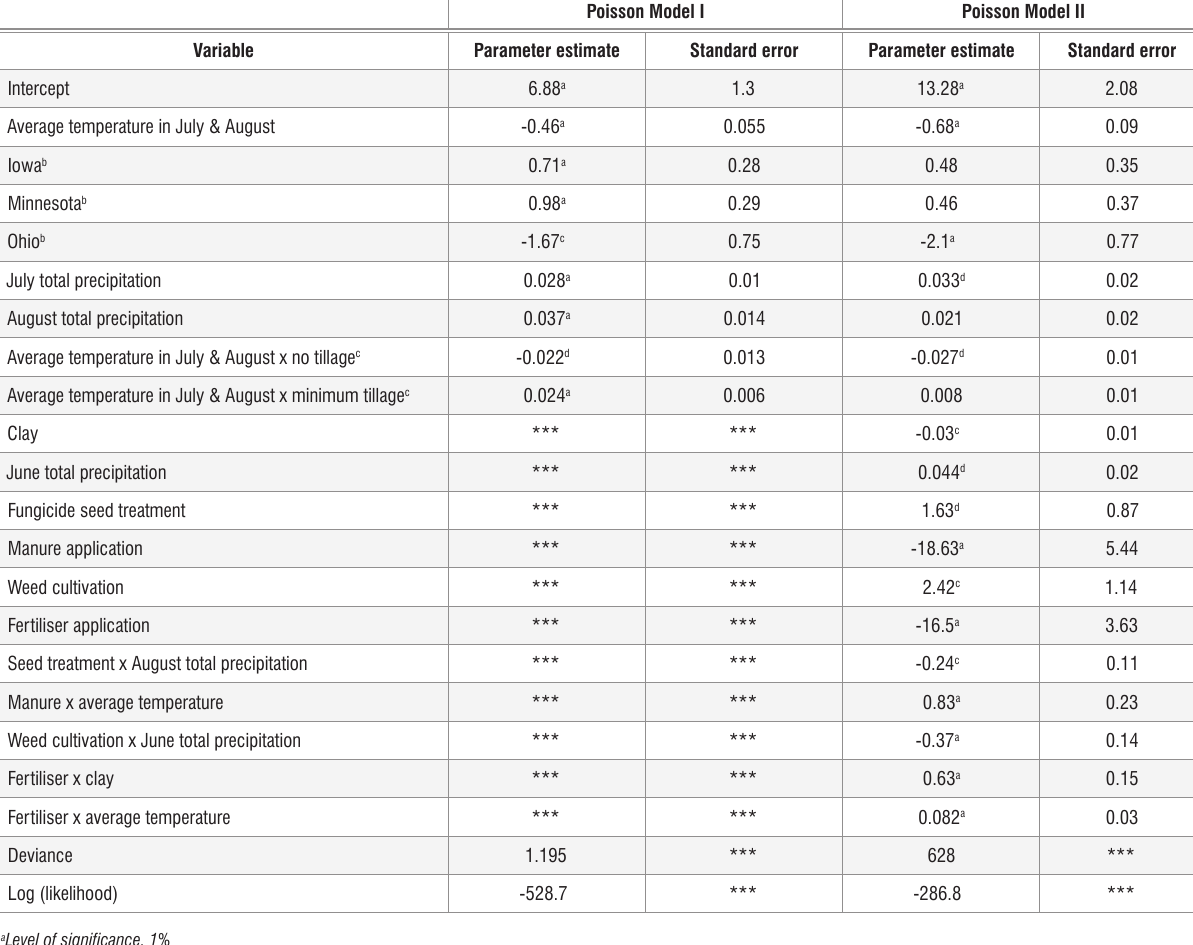
Parameter estimates of a Poisson regression analysis used to predict the incidence of soybean Sclerotinia stem rot (caused by Sclerotinia sclerotiorum ) using mid-western USA summer variables and agricultural management practices